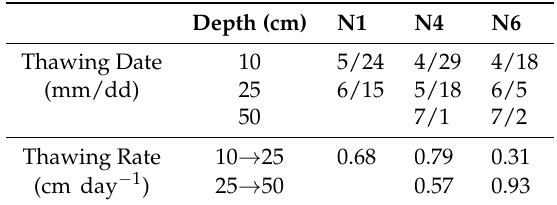
Table 3. Thawing dates for each depth at N1, N4, and N6, and thawing rates between depths. Thawing dates were defined as the day when the average daily soil temperature exceeded 0 degree. Thawing rate was calculated by dividing the difference in depth by the number of required days for thawing.